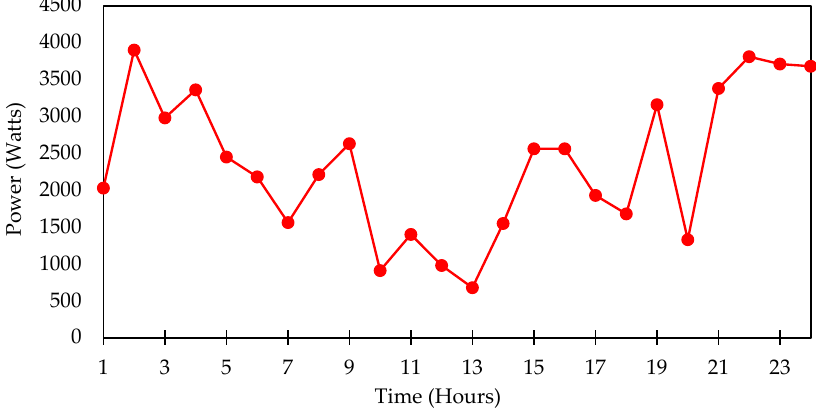
Figure 17. Demand curve of residential load.